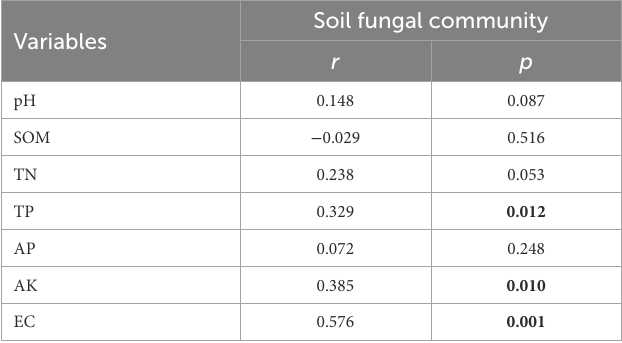
TABLE 1 Mantel tests of the soil fungal community with soil variables.